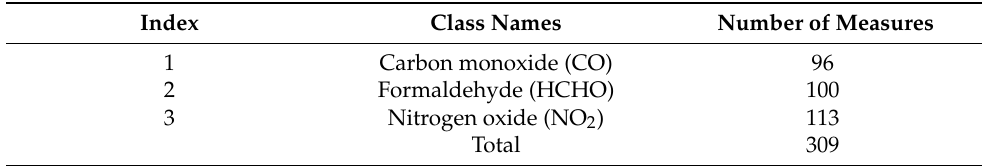
Table 3. Number of measures of the EN dataset